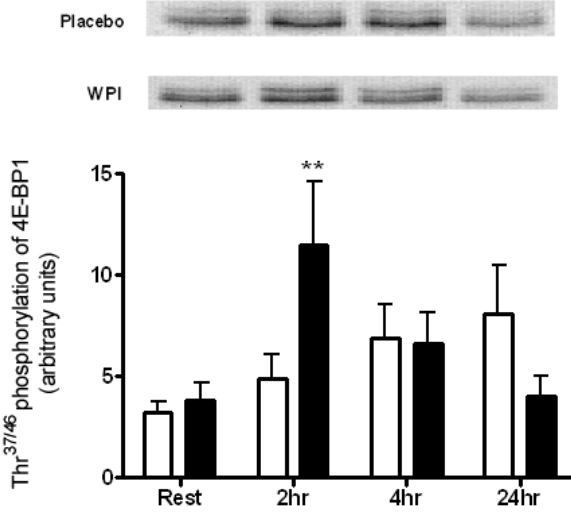
Figure 3 Phosphorylation of 4E-BP1 at Thr 37/46 in human skeletal muscle at rest and 2, 4 and 24 h post-exercise during placebo and WPI trials. Values are arbitrary units (mean ± SEM; n=7 per trial). Open bars represent placebo, closed bars represent WPI. ** P < 0.01 vs. resting values.